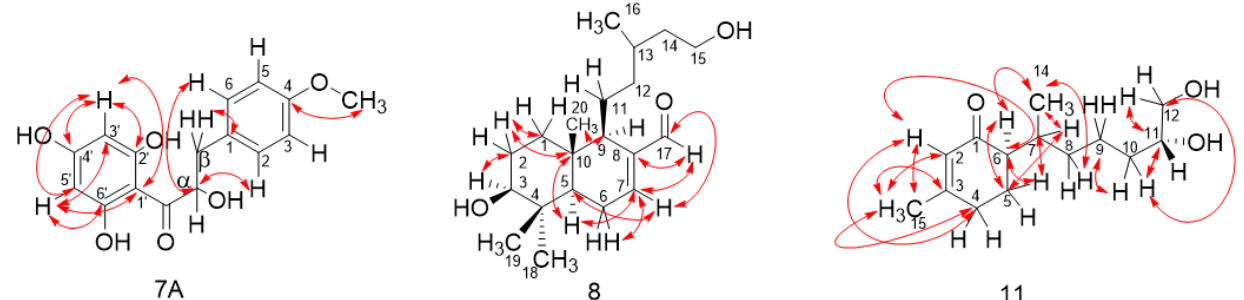
Figure 6. Structural analysis of 7A , 8 , and 11 , key 1 H- 13 C HMBC correlations. Compound 11 was isolated as a yellow oil with a specific rotation of [ α ] D25 : − 24.4. The analysis of the high-resolution mass spectrum (HRESIMS (+) [M + Na] + : 263.1623, found: 263.1611) confirms the molecular formula C 14 H 24 O 3 . NMR spectroscopic data of 11 1 H-NMR spectrum (Table 2 and Figure S14) showed the presence of a methyl group